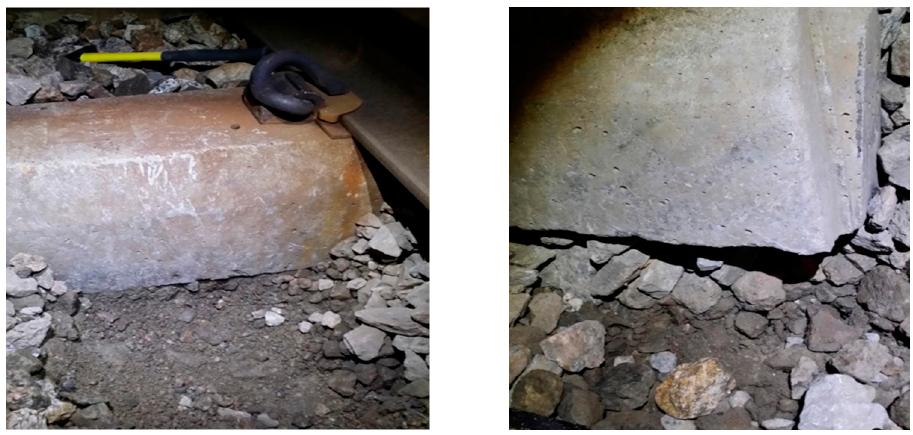
Figure 2. Damaged